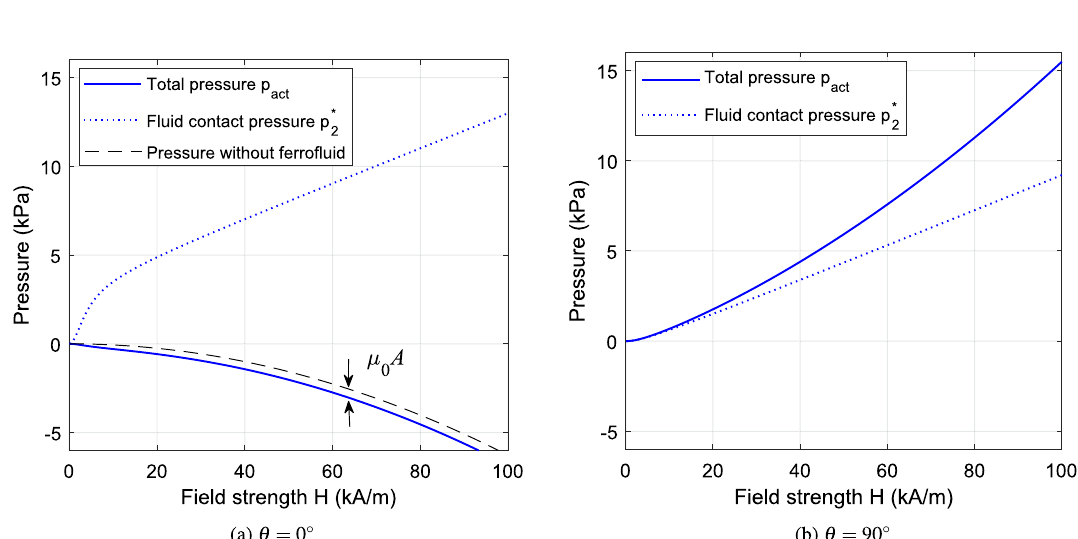
Figure 6. Dependency of transmitted pressure on field strength, accounting for magnetization saturation: ( a ) With axial field direction; ( b ) With orthogonal field